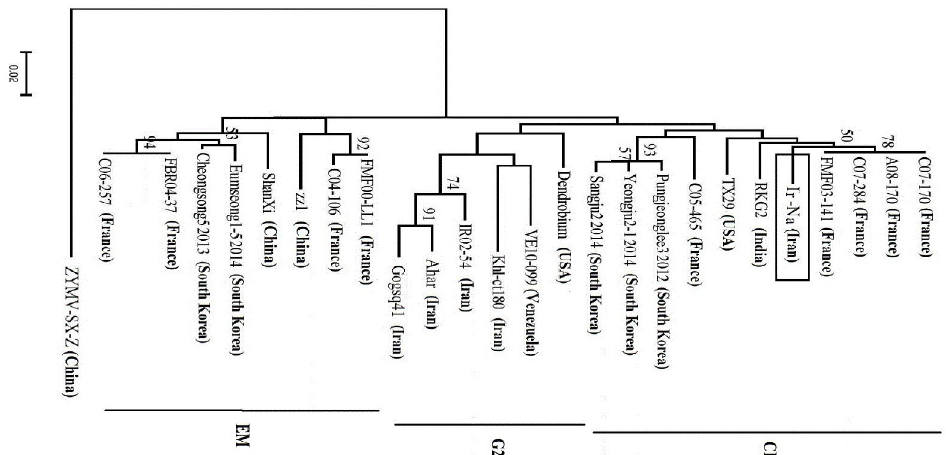
Fig. 3. Maximum-likelihood tree based on nucleotide sequences of the amplified 350 bp fragment from 26 Watermelon mosaic virus isolates including isolated from Iran (bolded). Multiple sequence alignments were generated with the MEGA program Version 6. Bootstrap values (>50%) are shown on the nodes. Zucchini yellow mosaic virus (KP710870) was included as an outgroup.